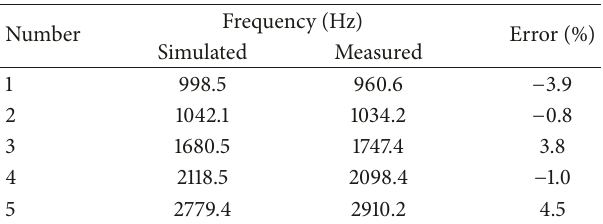
Table 2: Comparisons of simulated and measured natural frequen-